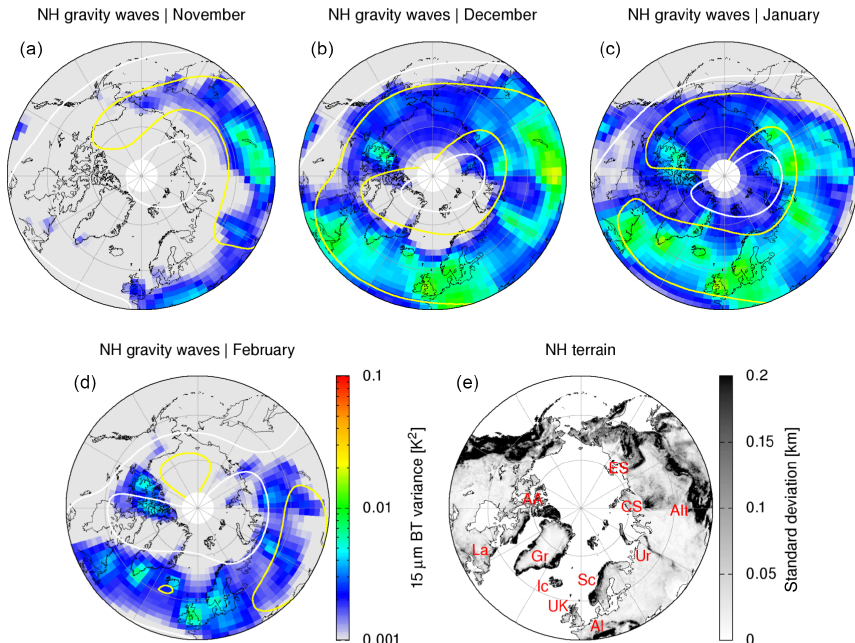
Figure 7. AIRS 2003–2012 monthly mean 15µm brightness temperature variances from November to March in the Northern Hemisphere. The contour lines show 30hPa ERA-Interim zonal winds at levels of 10ms − 1 (white), 20ms − 1 (yellow), 40ms − 1 (orange), and 60ms − 1 (red). The terrain height standard deviations on a 0 . 25 ◦ × 0 . 25 ◦ horizontal grid (bottom, right) indicate the source regions of mountain waves. The red labels in the terrain map indicate the locations of the Arctic Archipelago (AA), Labrador (La), Greenland (Gr), Iceland (Ic), the United Kingdom (UK), the Scandinavian Mountains (Sc), the Alps (Al), the Ural Mountains (Ur), the Altai Mountains (Alt), the Central Siberian Plateau (CS), and the East Siberian Plateau